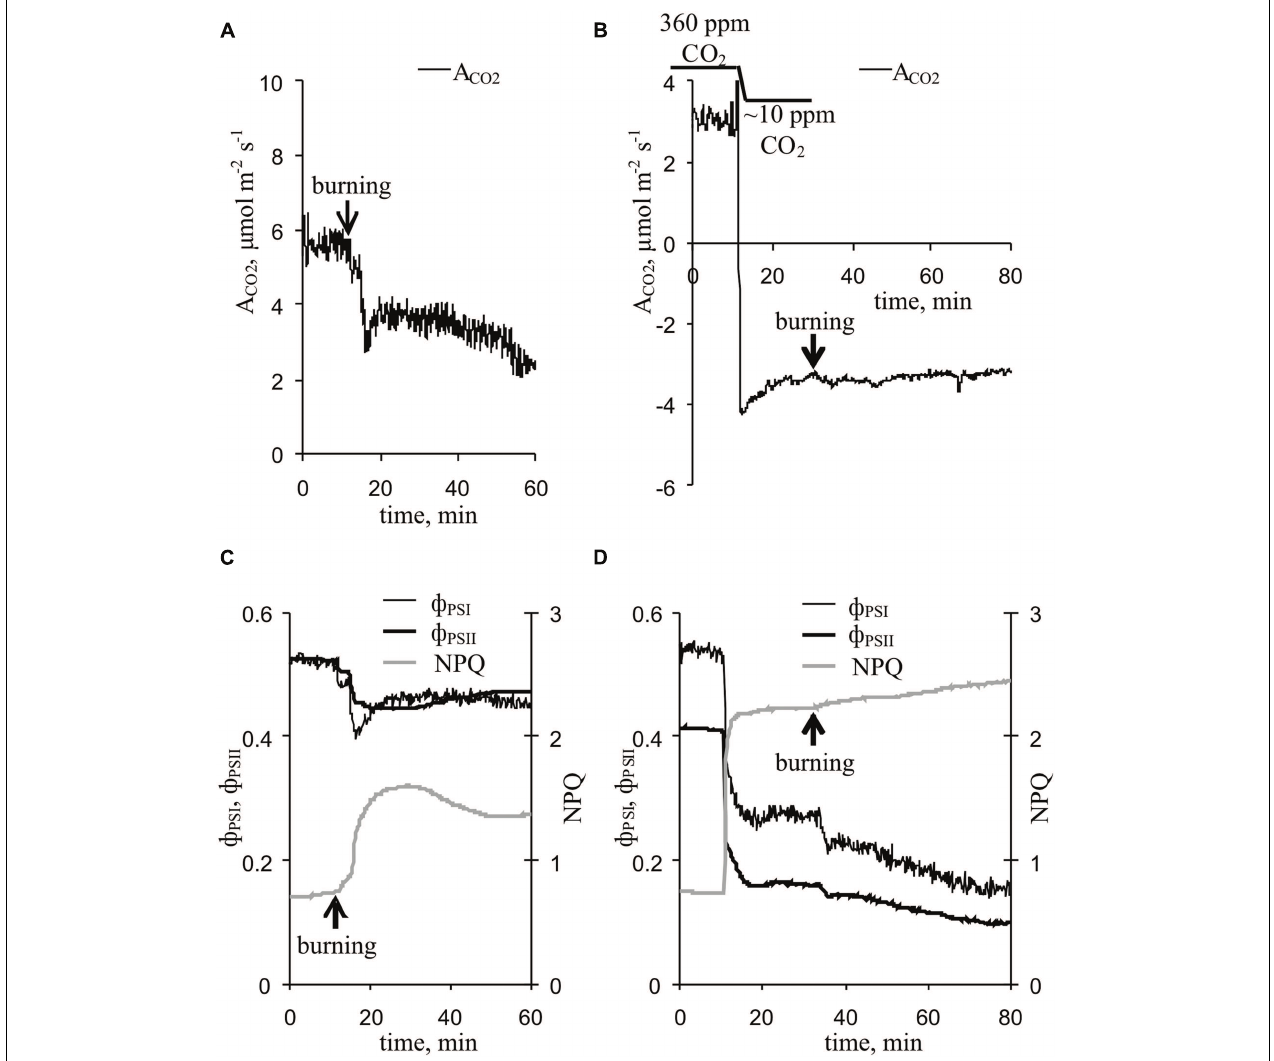
FIGURE 3 | Changes in the photosynthetic parameters induced by VP at 360 ppm and approximately 10 ppm CO 2 ( n = 5–10). (A) Changes in the A CO2 induced by VP at 360 ppm CO 2 . (B) Changes in A CO2 induced by VP at approximately 10 ppm CO 2 . (C) Changes in parameters of light reactions of photosynthesis induced by VP at 360 ppm CO 2 . (D) Changes in parameters of light reactions of photosynthesis induced by VP at approximately 10 ppm CO 2 . VP was induced by burning the first mature leaf